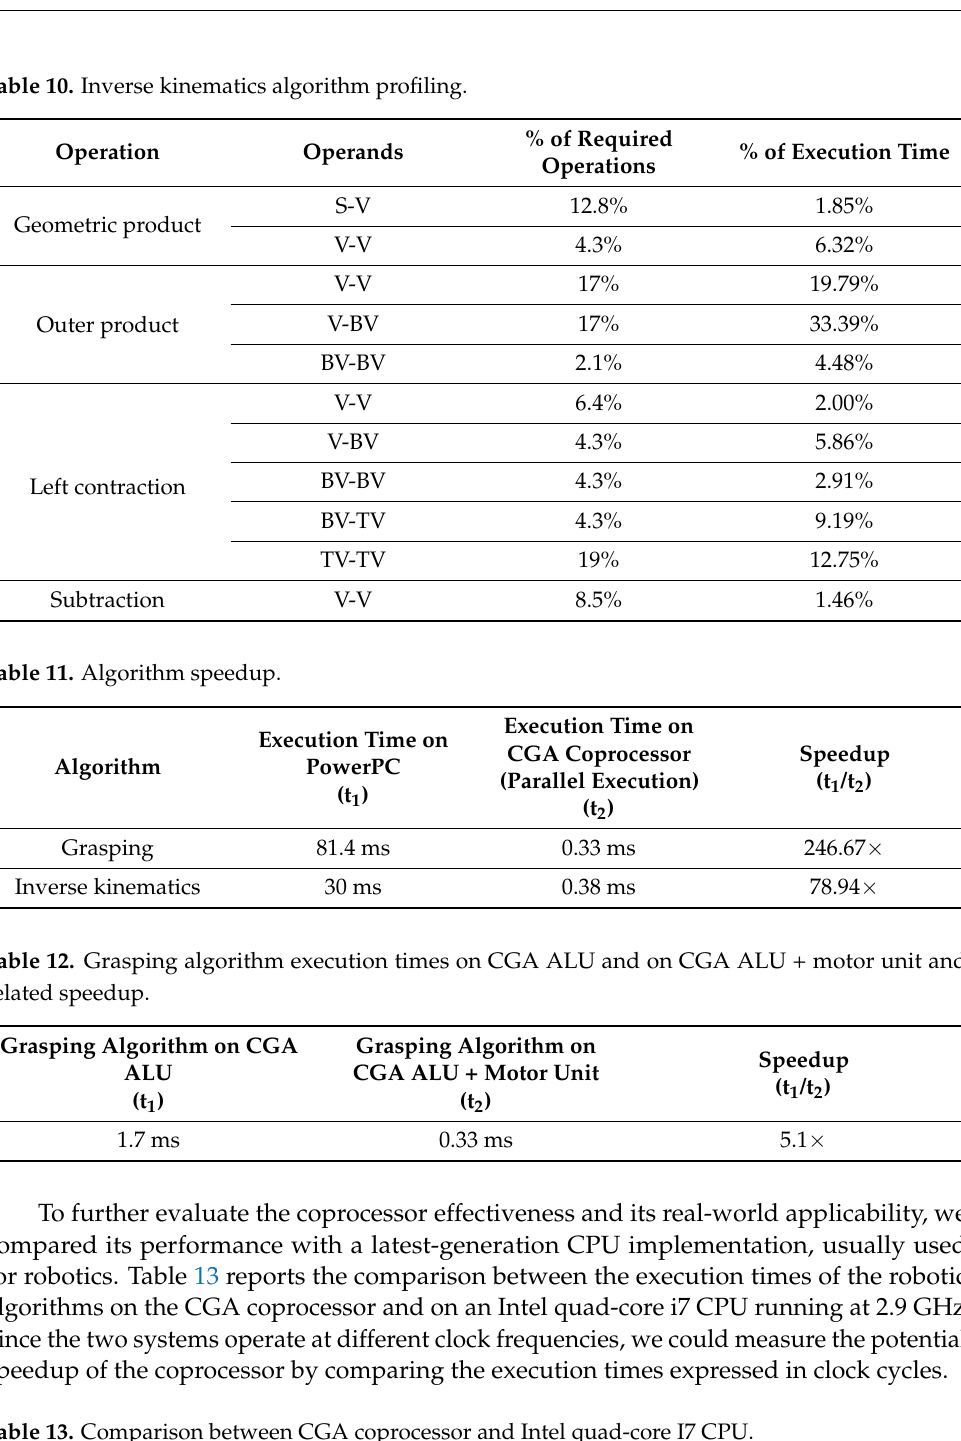
Table 13. Comparison between CGA coprocessor and Intel quad-core I7